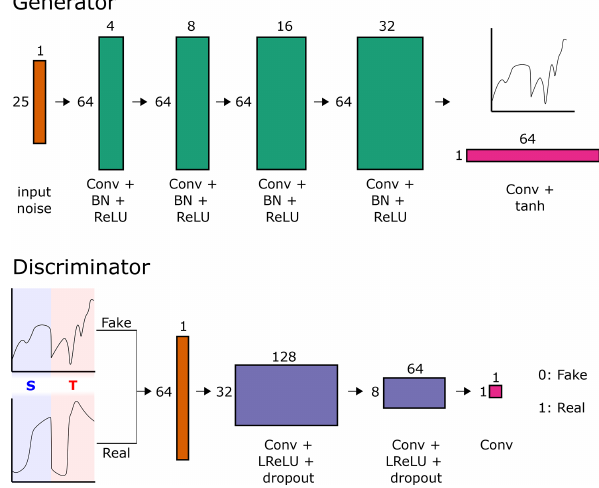
Figure D1. Schematic showing the GAN architecture, used to gen- erate synthetic temperature and salinity profiles from the WOA ob- servations. The generator network (top) takes a 25 × 1 random vec- tor and, through a series of convolution layers, outputs a synthetic combined profile. The discriminator network (bottom) is given both real and synthetic profiles and labels these as real or fake. Both net- works learn from one another, resulting in a generator network that can create an infinite number of realistic temperature and salinity profiles from random